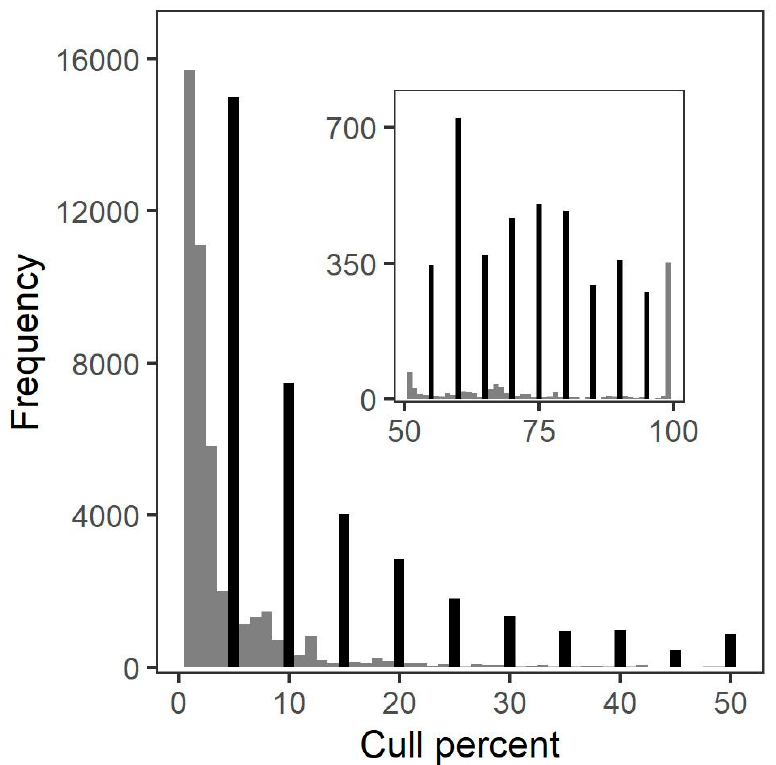
Figure 2. Distribution of rotten/missing cull volume > 0%. Darkest bars indicate values ending with the digit zero or five. Table 2. Estimated coefficients (and standard errors) for the model 𝑙𝑜𝑔𝑖𝑡(cid:4666)𝜋(cid:4667) = 𝛼 + 𝛽 𝛽 𝑥 + 𝛽 𝑥 predicting the probability that rotten/missing cull volume ends with the digit 0 or 5 by (cid:2871) (cid:2871) (cid:2872) (cid:2872) region.